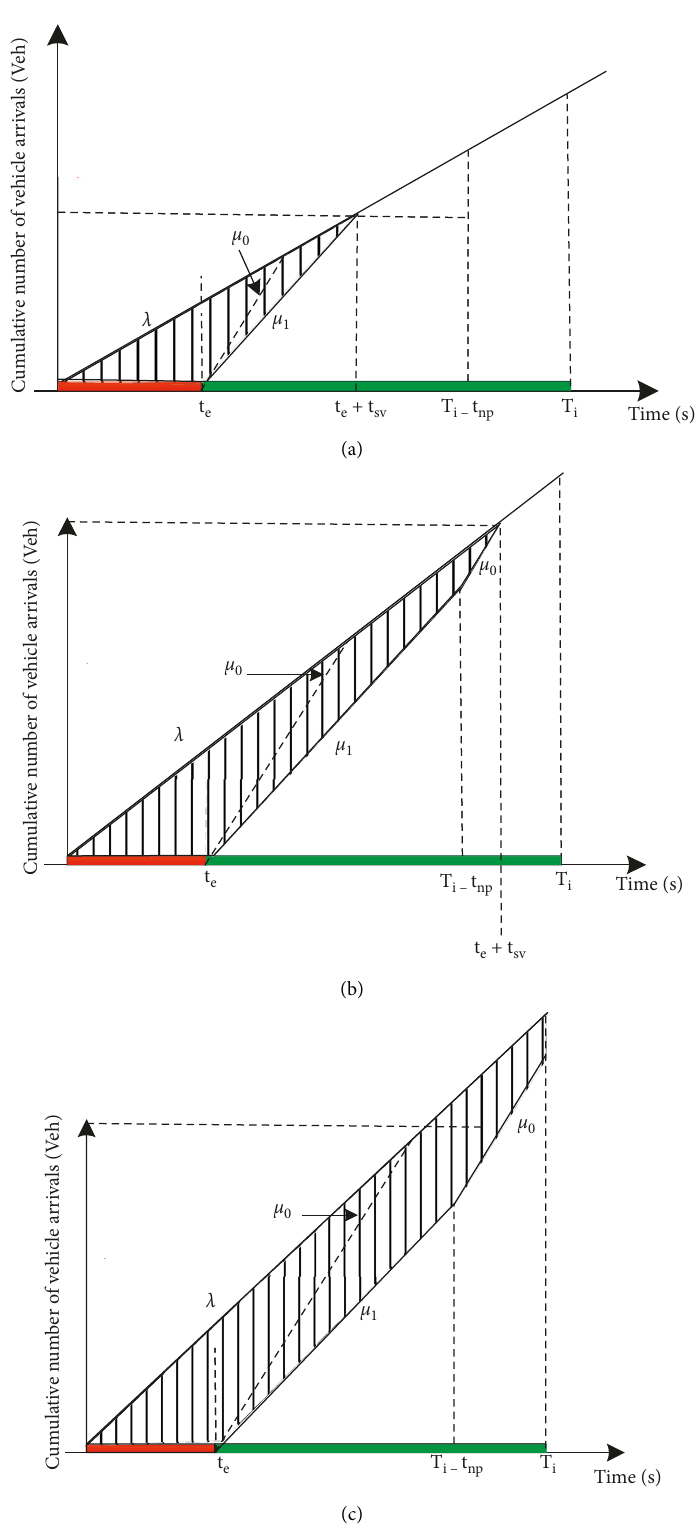
Figure 4: Three types of vehicle cumulative dissipation. (a) Cumulative vehicle dissipation form 1. (b) Cumulative vehicle dissipation form 2. (c) Cumulative vehicle dissipation form